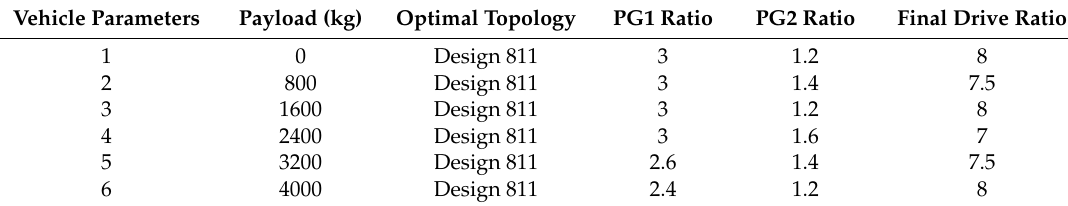
( A ) lever diagram of the Design 811; and ( B ) operating modes of the optimal powertrain Design 811.